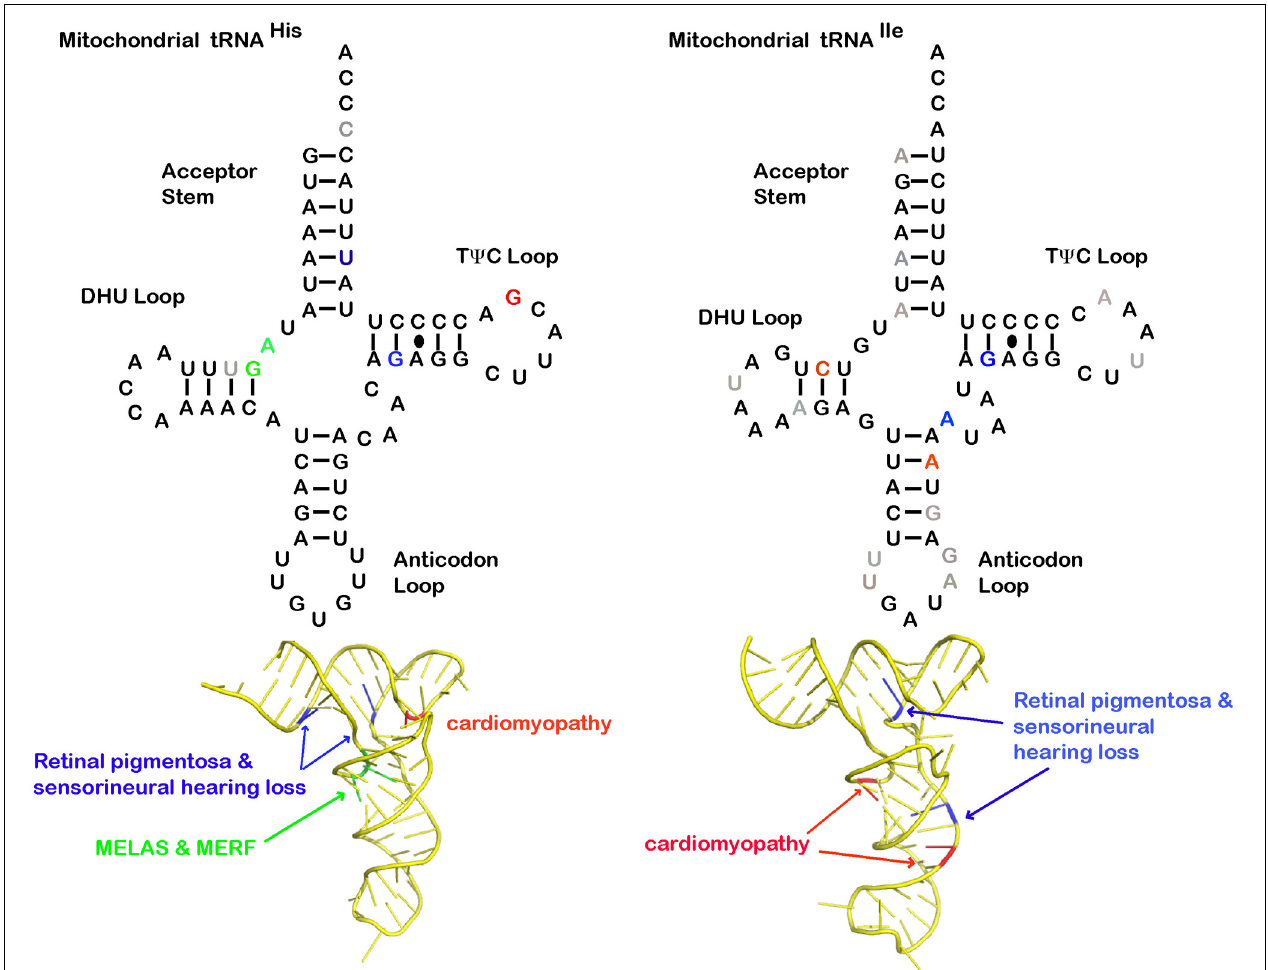
FIGURE 1 | Structural analysis of mitochondrial tRNA and disease causing mutations. Cloverleaf structure of mt-tRNA His and mt-tRNA Ile . Mutations discussed in this review that cause neurosensory disease (blue), cardiomyopathy (red), MELAS and MERRF (green), and other pathological reported mutations not discussed in this review (gray).